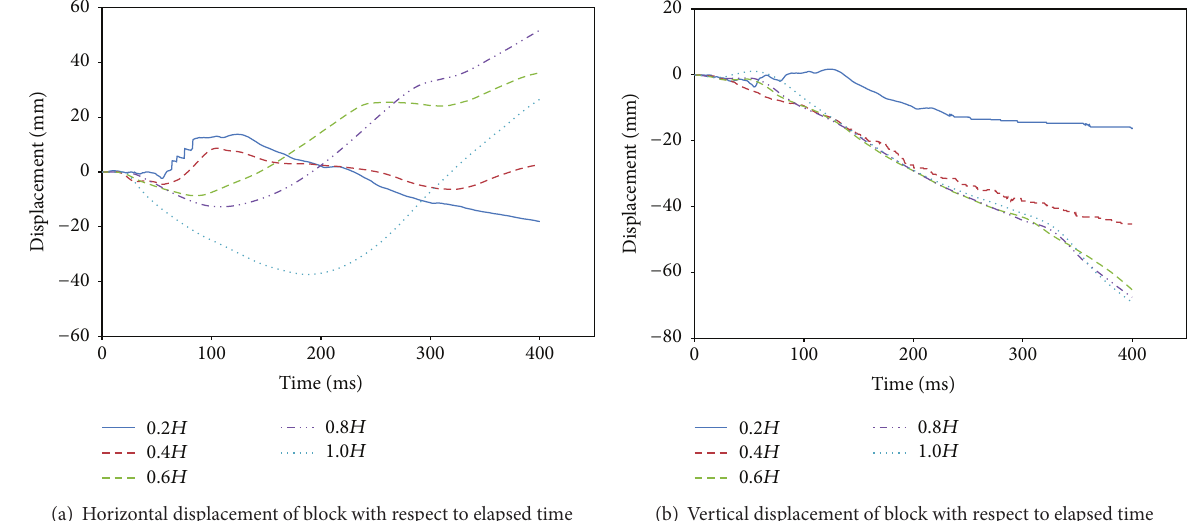
Figure 6: Block displacement for 200 mm reinforcement spacing.